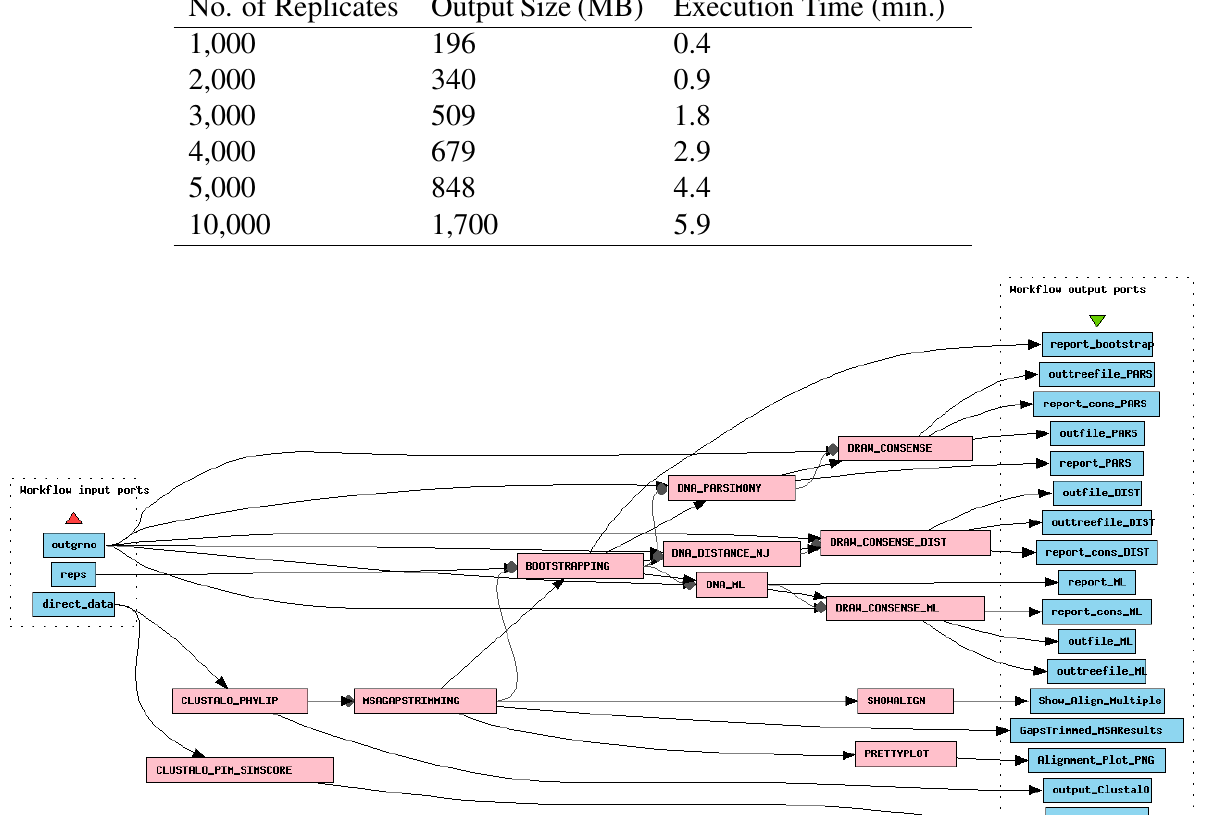
Table 4: The performance tests of the bootstrapping workflow for DNA of the 13-CDS dataset using local services